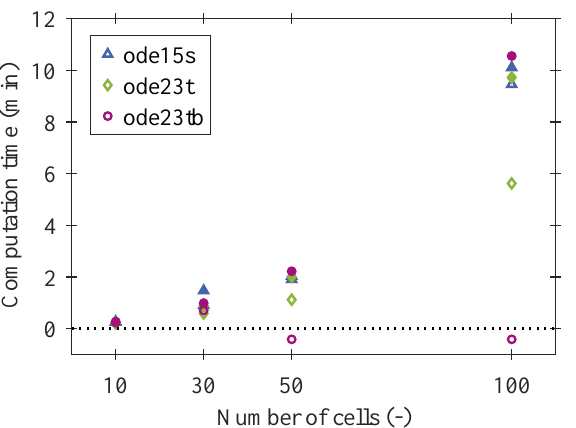
Figure 3. Required computation time depending on the number of implemented cells, chosen solver, and relative error tolerance. Filled symbols: relative error tolerance 10 − 6 ; open symbols: relative error tolerance 10 − 3 . The best results for N = 100 are obtained for solver ode23t with a relative error tolerance of 10 − 3 . Computation times below 0 indicate that a simulation did not